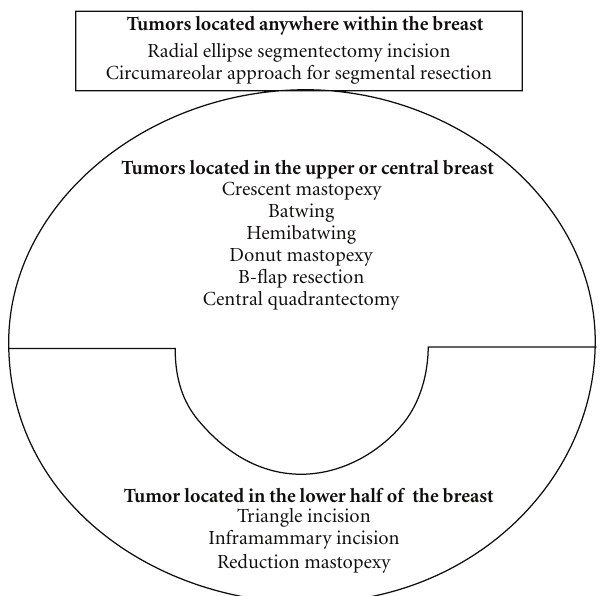
Figure 1: List of oncoplastic breast conserving procedures dis- cussed in this paper, organized by tumor